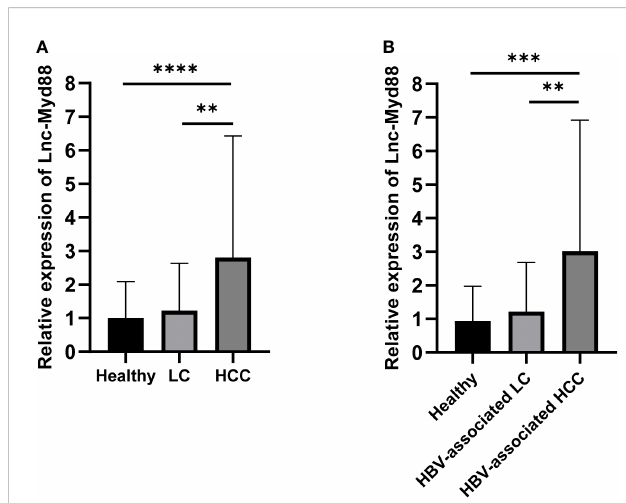
FIGURE 1 (A) Relative expression levels of lnc-MyD88 in HCC patients, LC patients, and normal people. (B) Relative expression levels of lnc- MyD88 in HBV-associated HCC patients, HBV-associated LC patients, and normal people. ** P < 0.01, *** P < 0.001, **** P < 0.0001. LC, liver cirrhosis; HCC, Hepatocellular carcinoma; HBV, Hepatitis B virus; Lnc- Myd88: Long noncoding RNA-Myd88.